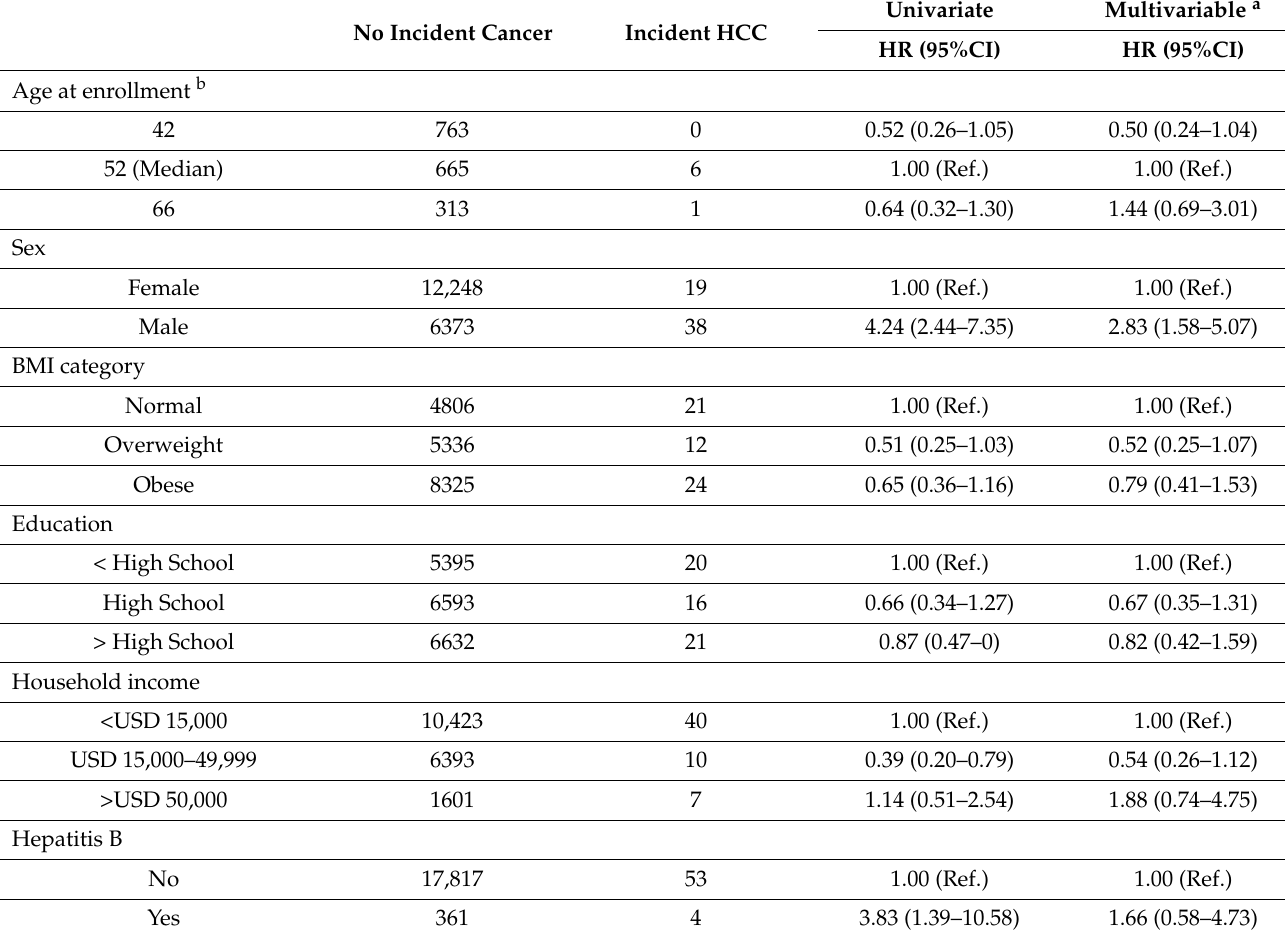
Table 3. Univariate and multivariable hazard ratios (HR) and 95% confidence intervals (95%CI) for risk factors associated with hepatocellular carcinoma (HCC) incidence among White